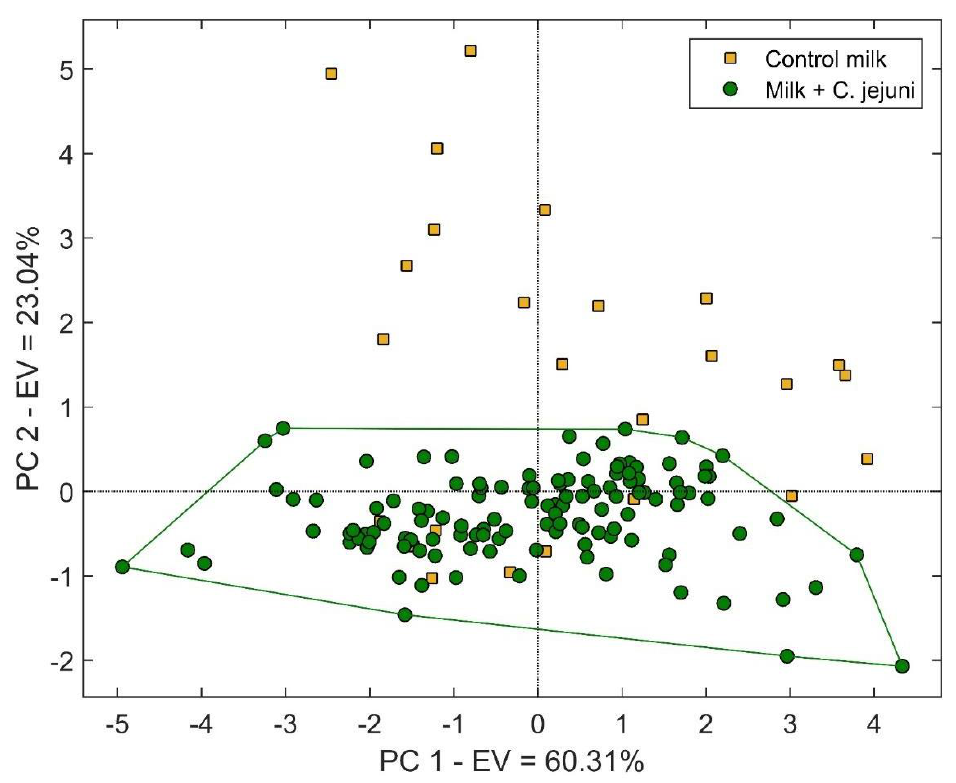
Figure 2. Principle component analysis (PCA) score plot representing the data obtained during the 93 h of the first set of analysis where contaminated samples are dots colored in green while control samples are yellow squares. The horizontal axis represents the explained variance enclosed in PC1 as equal to 60.31%, conversely, the vertical axis represents the explained variance enclosed in PC2 as equal to 23.04%. The total explained variance enclosed in the graphic is equal to 83.35%.